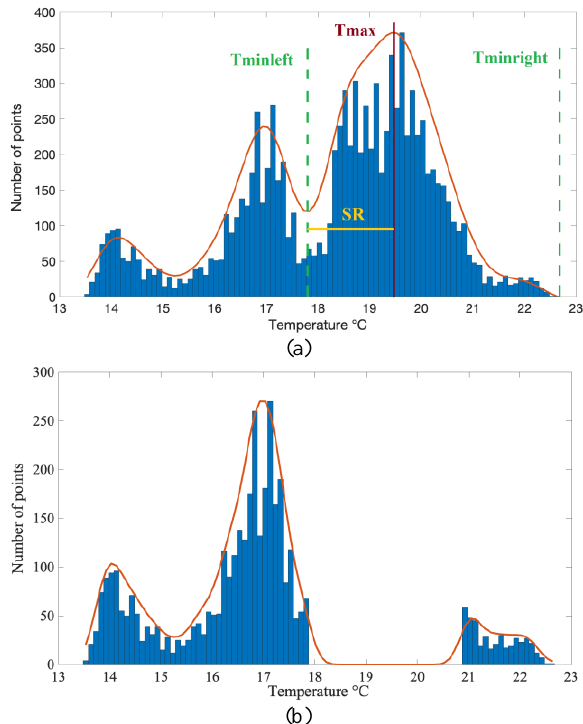
Figure 2: Histogram analysis: (a) approximation of the histogram by a curve; (b) remaining histogram after first